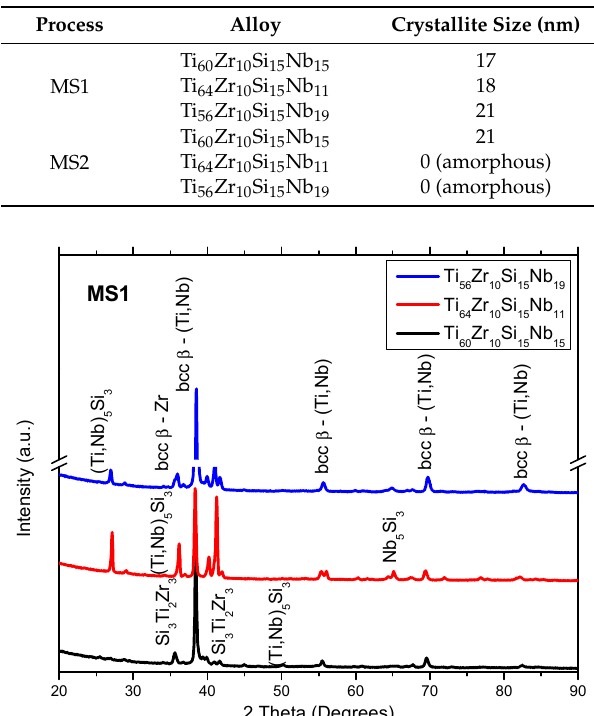
Figure 2 . X-ray diffraction patterns of Ti–Zr–Si–Nb alloys obtained with 28 m/s peripheral speed— MS1.